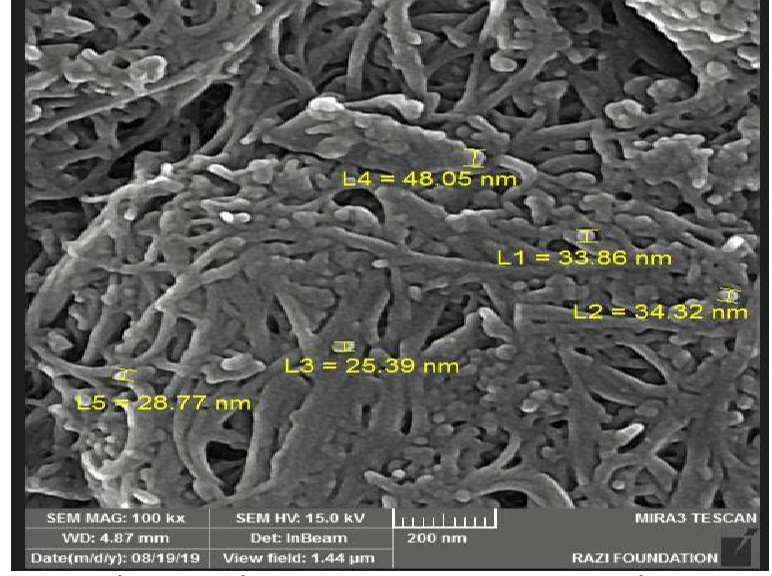
Fig.2: SEM image of F-SWCNT/CoO